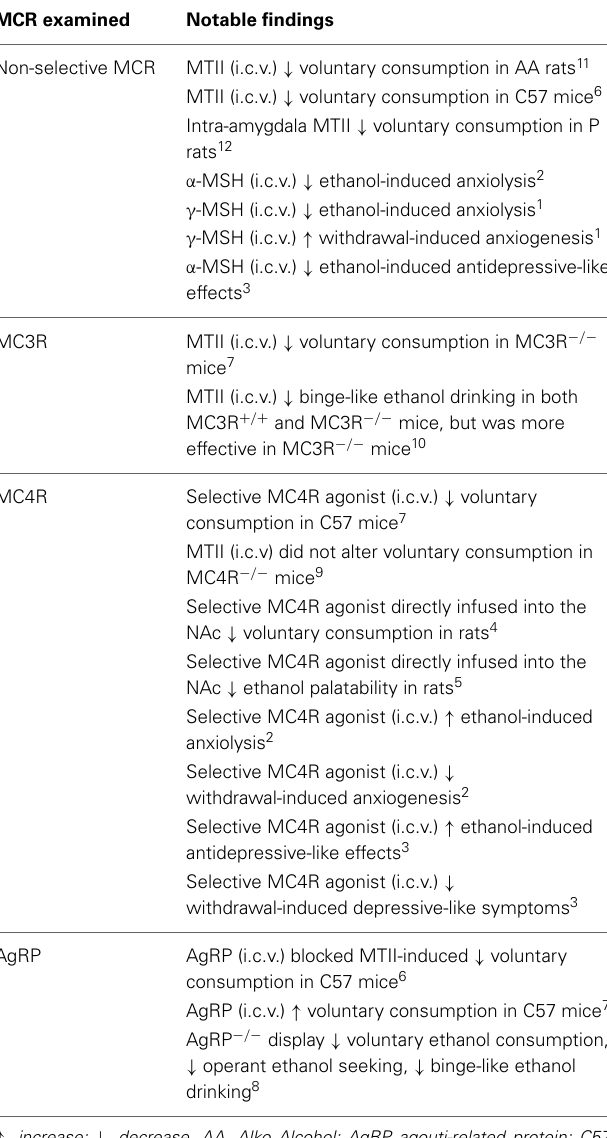
Table 2 | Summary of findings targeting the melanocortin system on ethanol-related